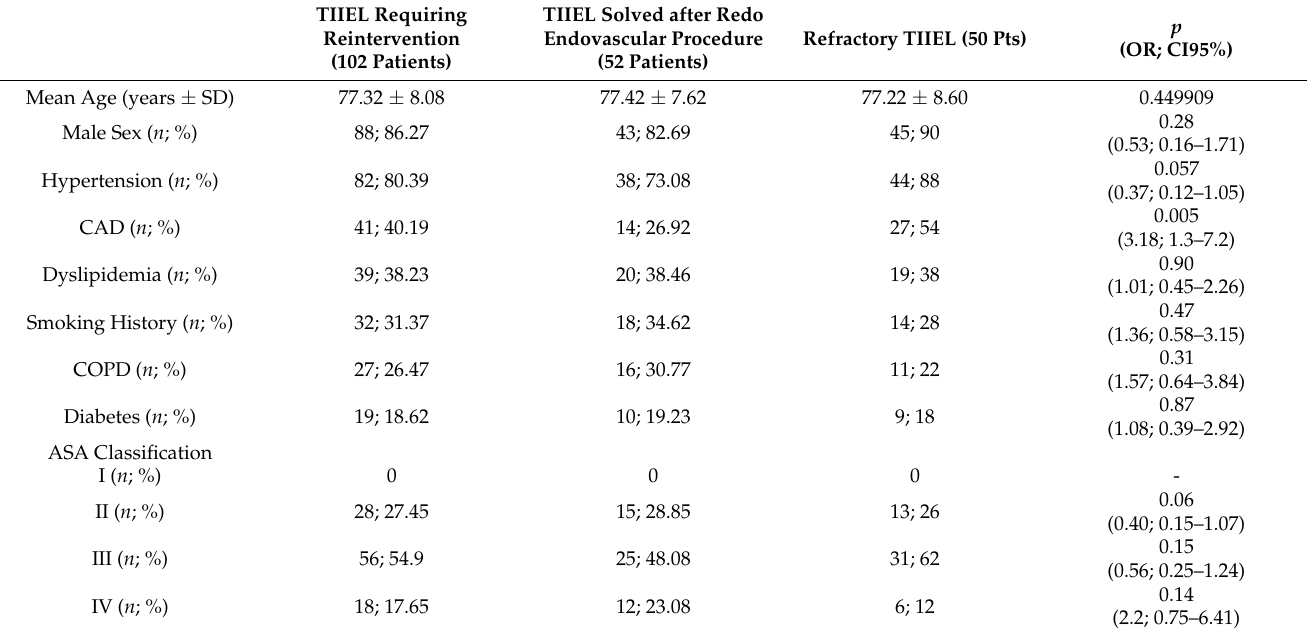
Table 1. Preoperative demographic and clinical characteristics of patients included in present